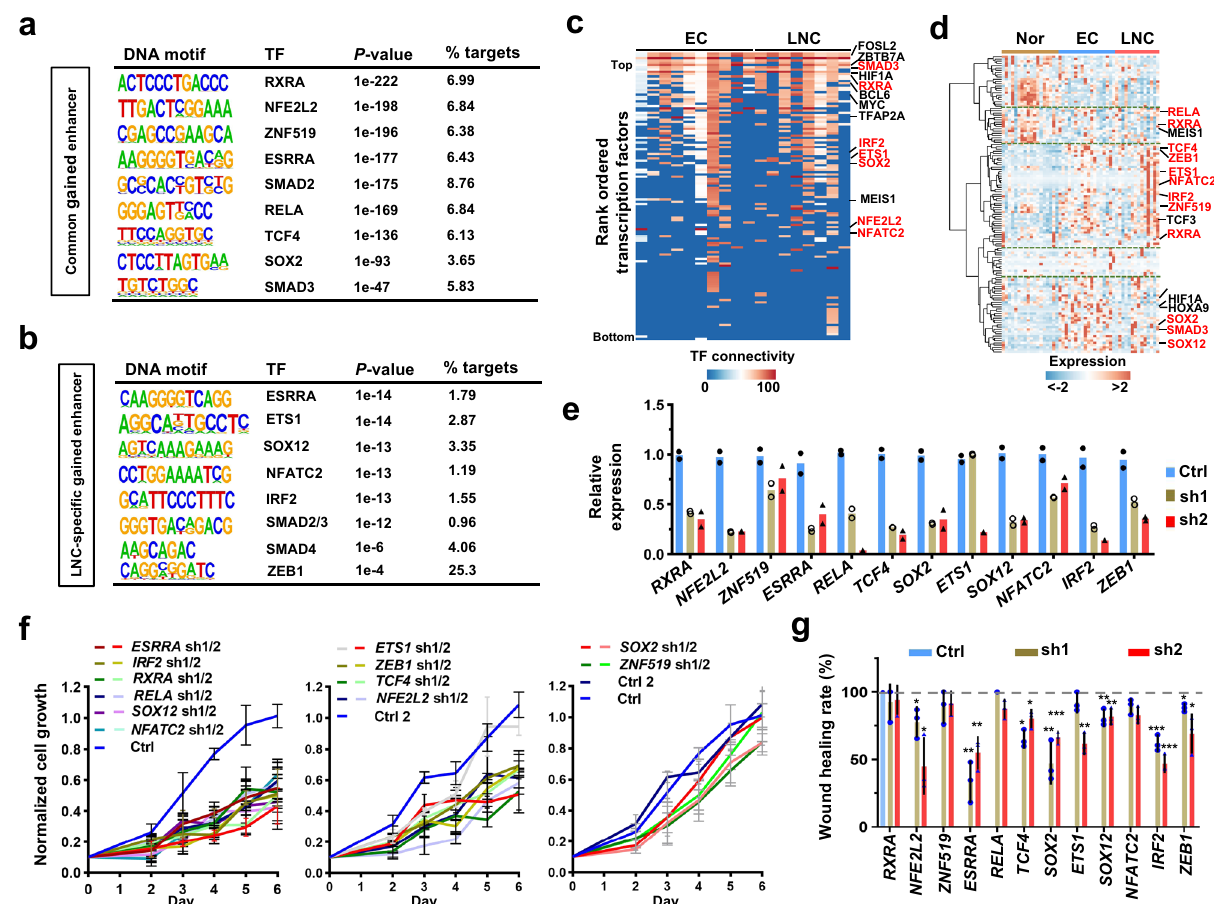
Fig. 4 Transcription factor circuitries of esophageal carcinogenesis and metastasis. a , b Top transcription factor (TF) binding motifs predicted from common gained ( a ) or LNC-speci fi c gained ( b ) enhancers using HOMER. The predicted TFs are ranked by their P value (two-sided binomial test), and the proportion of targets potently regulated by these TFs is also presented. c Heatmap of TFs ranked by their predicted activity using core circuitry analysis. Representative genes with high TF connectivity are presented. d Heatmap showing the expression of common gained or LNC-speci fi c gained enhancer predicted TFs in the Nor, EC, and LNC groups. The TFs shown in a , b are highlighted in red. e Assessment of knockdown ef fi ciency by shRNAs. Two shRNAs were constructed for each TF, and shRNA expressing TE1 cells were subjected to quantitative real-time PCR analysis. The expression of each TF in control cells expressing the control shRNA was normalized to “ 1 ” . Ctrl, control. n = 2 biologically independent experiments examined. f Control or shRNA expressing TE1 cells were counted using a cell counter and control cells were duplicated in this experiment (Ctrl and Ctrl2). The number of cells from three wells was averaged as a single replicate for each sample, and results were obtained from three replicates. The time course curve of the normalized cell number was plotted. Data were presented as mean values ± s.d. n = 3 biologically independent experiments examined. g Wound healing assays were performed with control and shRNA expressing TE1 cells, and the wound healing rate was calculated for each group. The wound healing rate was calculated as shown in Supplementary Fig. 17b. Data were presented as mean values ± s.d. n = 3 biologically independent experiments examined. Statistics: * P <